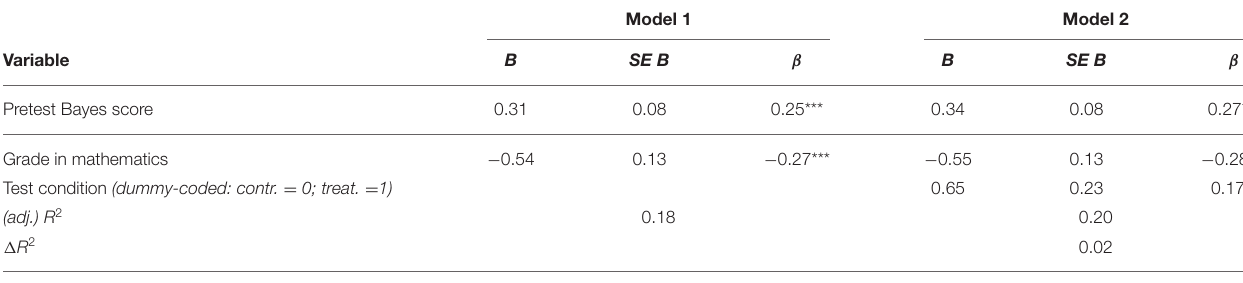
TABLE 2 | Prediction of the posttest results of the Bayesian tasks.